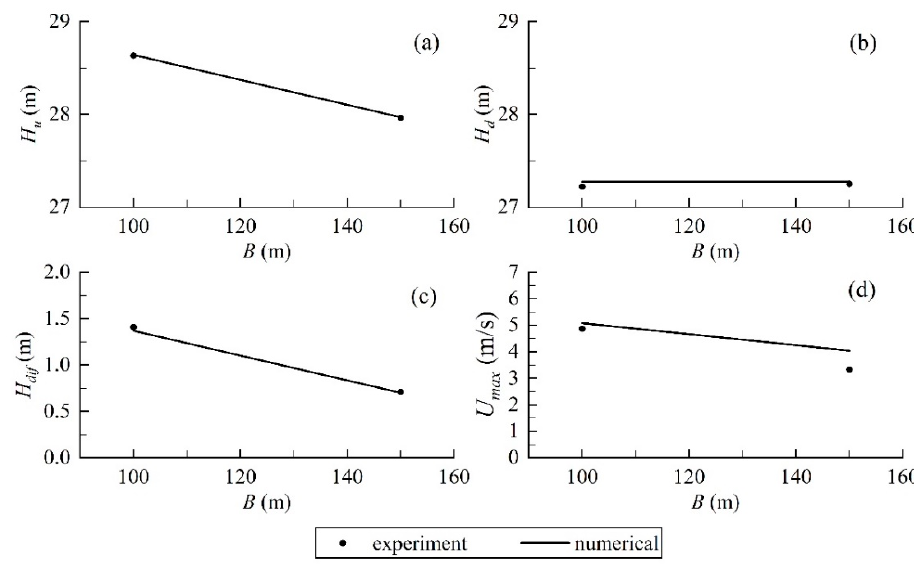
Figure 7. Comparison between numerical results and experimental data under working condition 1: ( a ) upstream water level; ( b ) downstream water level; ( c ) water level difference; ( d ) maximum velocity .